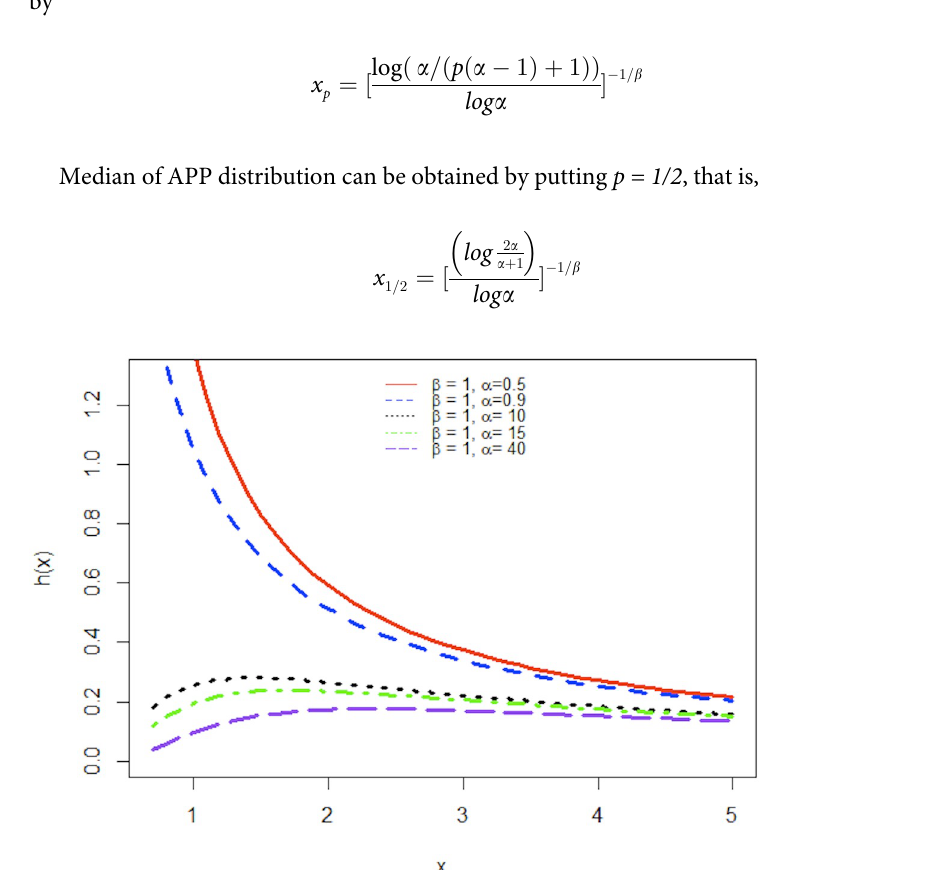
Fig 2. Increasing, decreasing shapes of hazard function of APP